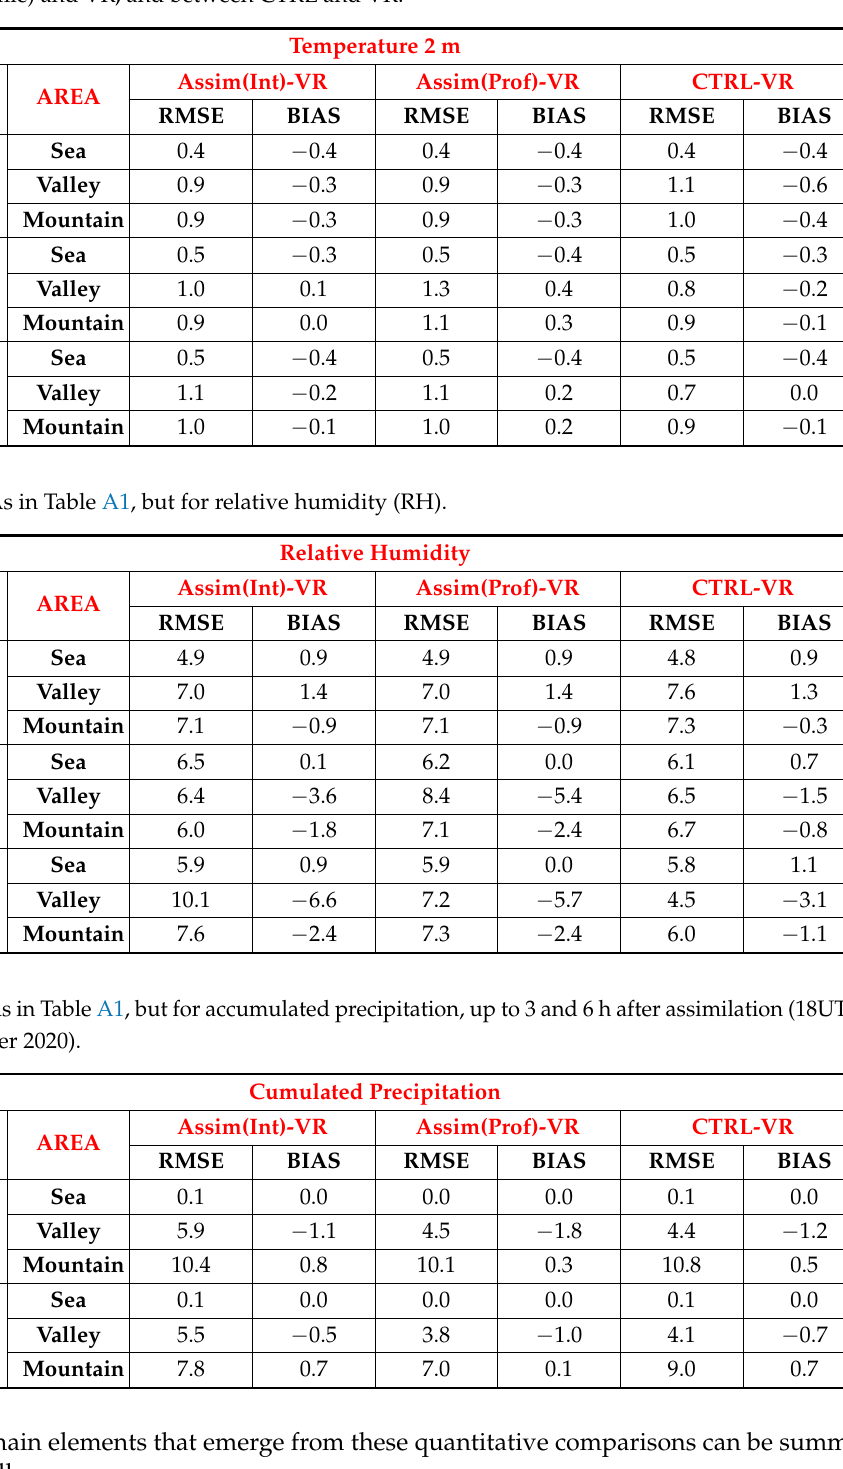
Table A1. RMSE and BIAS for the temperature at 2 m for the period from 18UTC of 24 September to 00UTC of 25 September 2020, and for the three selected areas (Sea, Valley, Mountain). The table shows the results of the comparison between the two ASSIM runs (Int: integrated PW, and Prof: WV vertical profile) and VR, and between CTRL and VR.